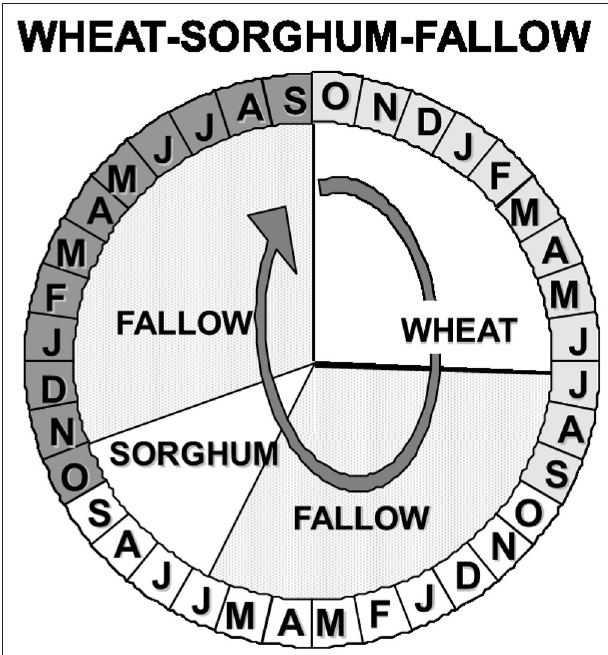
FIGURE 1 | The wheat-sorghum-fallow crop rotation diagramed as a clock-like 3-years cycle beginning with wheat establishment in October. Wheat is harvested in July and subsequently fallowed until June of the 2nd year (11-months) when grain sorghum is established. After sorghum harvest in November of the 3rd year, fallow is again maintained until wheat is planted and the cycle repeated.